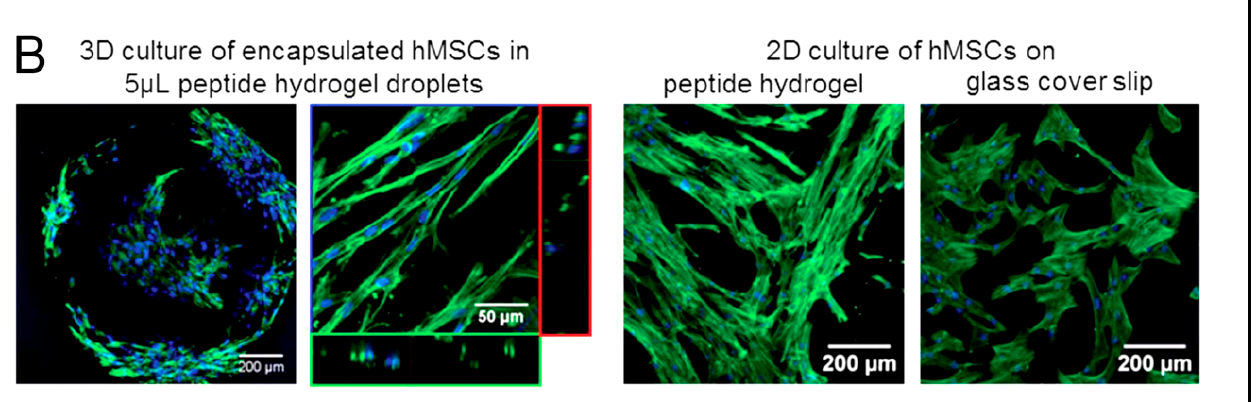
Figure 6. Ultrashort peptide hydrogels encourage the proliferation of encapsulated stem cells for regenerative medicine. ( A ) Human H1 embryonic stem cells encapsulated in 8 mg/mL Ac-ILVAGK-NH2 hydrogels retain their pluripotency, as reflected by the staining of nuclear transcription factors Oct4 and Nanog (red) and surface biomarkers Tra-I-60 and Tra-I-81 (green). ( B ) Human mesenchymal stem cells (hMSCs) encapsulated in 5 μ L 10 mg/mL Ac-ILVAGK-NH2 hydrogel droplets and cultured on hydrogel films elongated along the peptide fibers, as reflected by the staining of their actin cytoskeleton (green). On glass coverslips, the cells are well spread out and non-aligned. Reprinted with permission from Ref. [187], Copyright 2015, American Chemical Society.